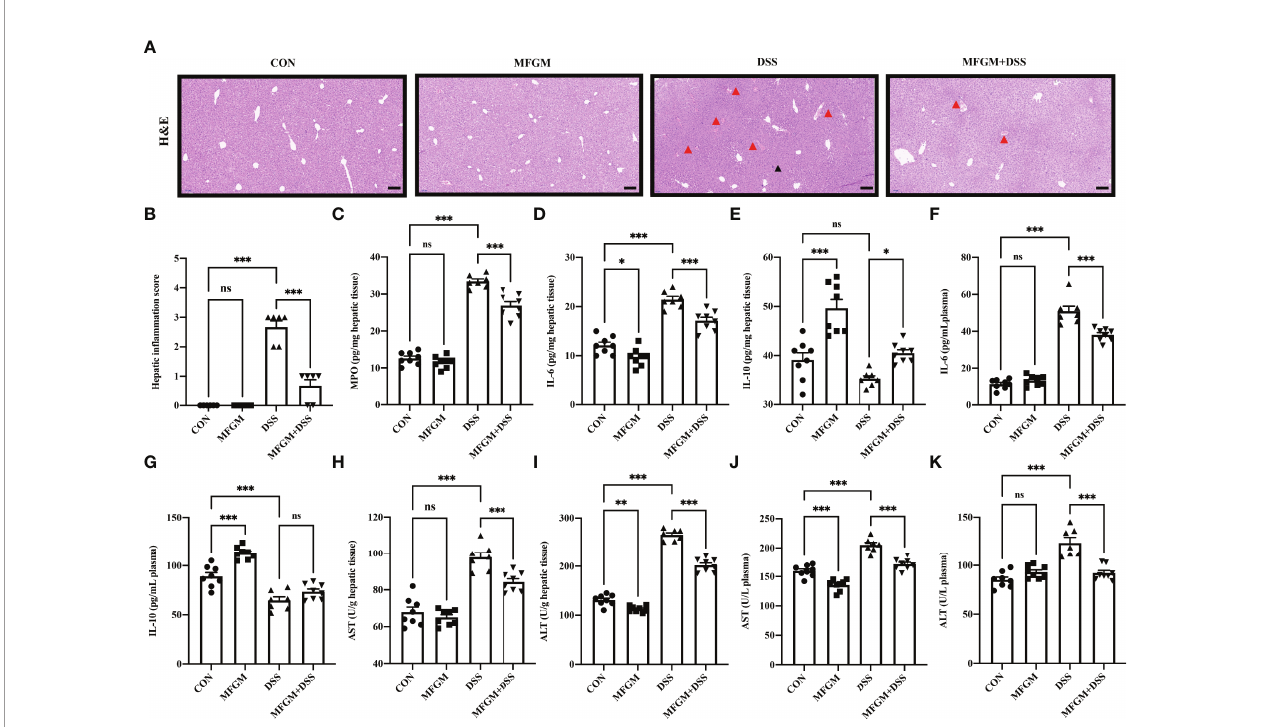
FIGURE 4 | Milk fat globule membrane alleviated hepatic injury secondary to dextran sulfate sodium-induced experimental colitis. (A) H&E-stained liver sections and (B) hepatic in fl ammation scores of livers ( n = 6 per group). Scale bars represent 100 m m. The in fi ltration of immunocytes was marked by black triangles, and local bleeding was marked by red triangles. Concentrations of MPO (C) , IL-6 (D) , and IL-10 (E) in the liver from each group. Levels of IL-6 (F) and IL-10 (G) in the plasma. Concentrations of AST (H) and ALT (I) in the liver ( n = 6 – 8 per group). Concentrations of AST (J) , and ALT (K) in the plasma ( n = 6 – 8 per group). Data are presented as means ± SEM. Statistical signi fi cance was determined using one-way ANOVA, followed by Tukey ’ s test. ns, no signi fi cant, *P < 0.05, **P < 0.01, ***P <